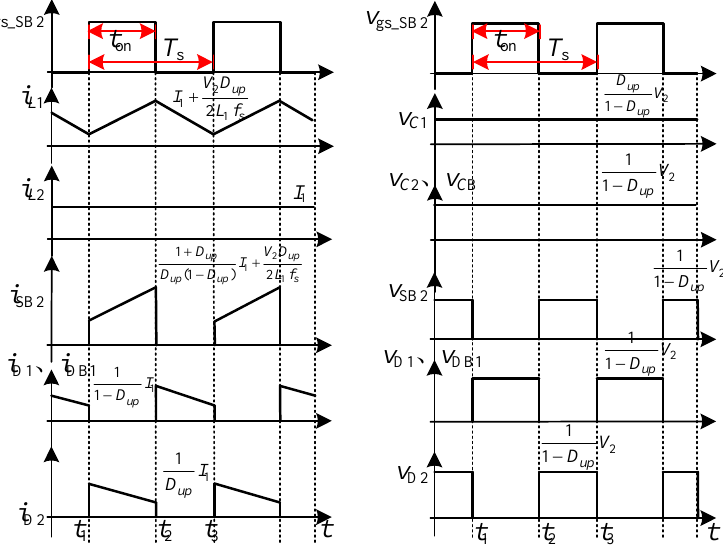
Figure 4. The operation waveforms of main components in step-up mode.